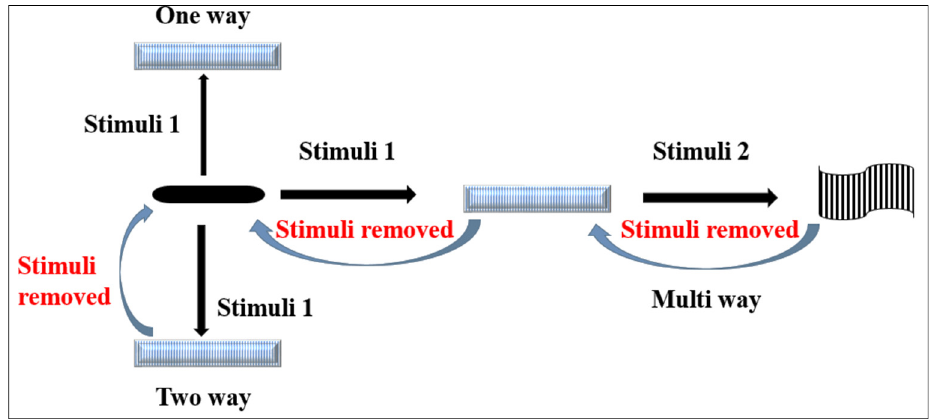
Figure 1. Schematic illustration of various shape transformations (one way, two way, and multiway) in response to stimuli.